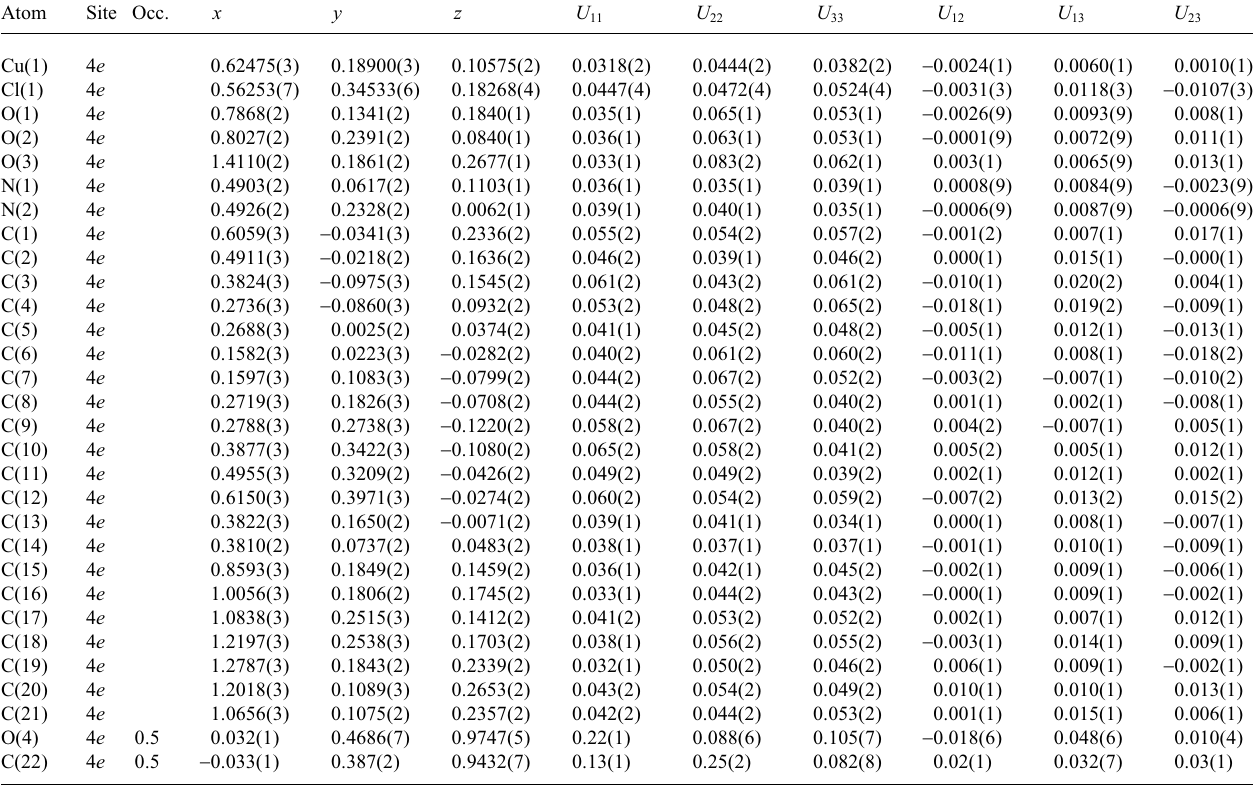
Table 3. Atomic coordinates and displacement parameters (in Å 2 )